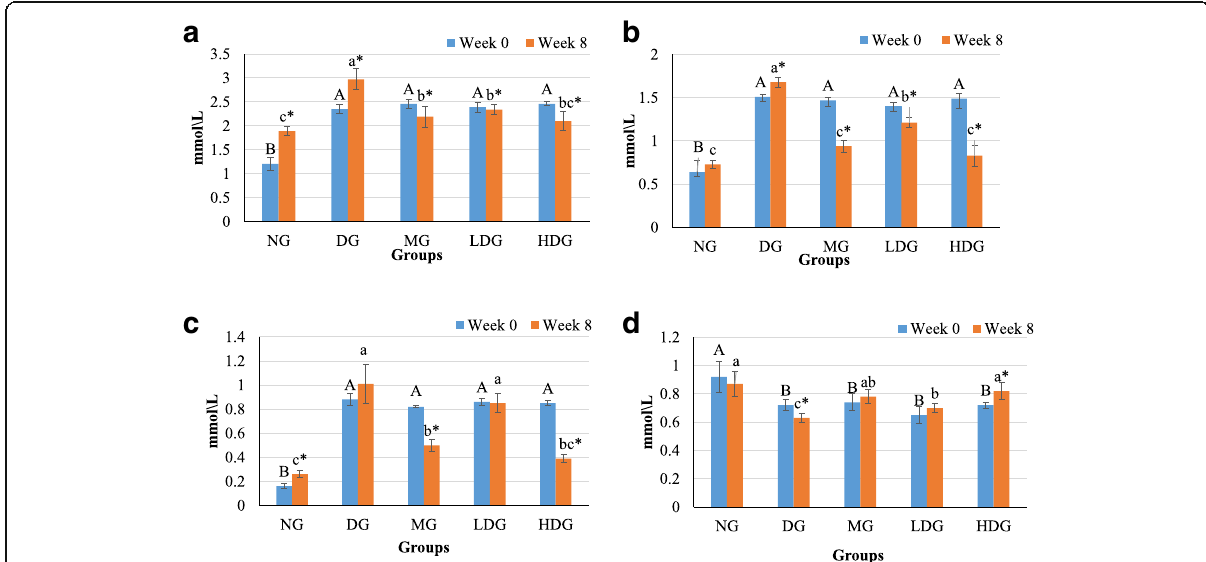
Fig. 5 a Total cholesterol levels, b Triglycerides levels, c LDL levels and d HDL levels of normal diet group (NG), diabetic group (DG), metformin group (MG) low dose group (LDG) and high dose group (HDG) before and after